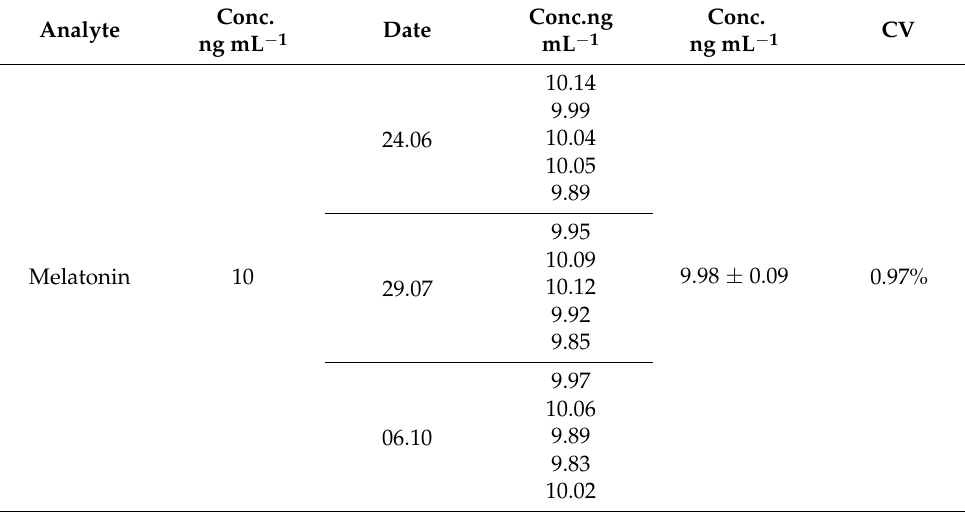
Table 3. The experimental results obtained to demonstrate the reproducibility of the HPLC- FL